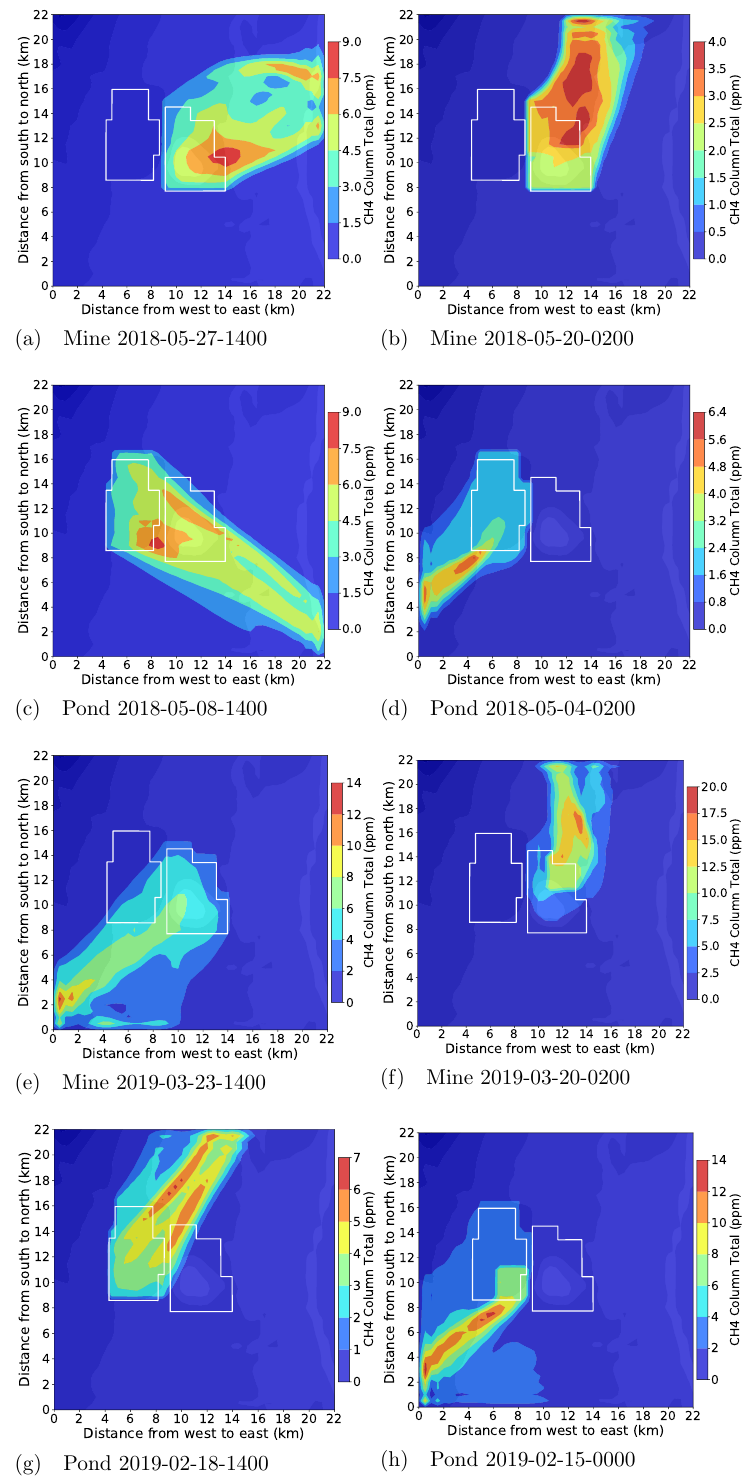
Figure 5. WRF-simulated total-column mixing ratio of methane; the white lines show the perimeter of area sources for methane mixing ratio boundary condition for the mine and pond; times in local standard time (LST = UTC − 7); ( a ) Mine 2018-05-27-1400; ( b ) Mine 2018-05-20-0200; ( c ) Pond 2018-05-08-1400; ( d ) Pond 2018-05-04-0200; ( e ) Mine 2019-03-23-1400; ( f ) Mine 2019-03-20-0200; ( g ) Pond 2019-02-18-1400; ( h ) Pond